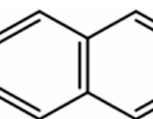
Figure 3. Molecular structure of α -Methylnaphthalene ( a ) and β -Methylnaphthalene ( b ).